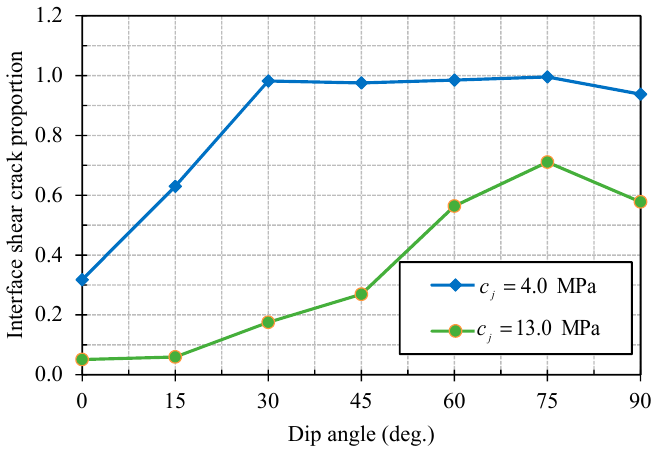
Figure 22. Interface shear crack proportion variation with different bonded joint cohesion.